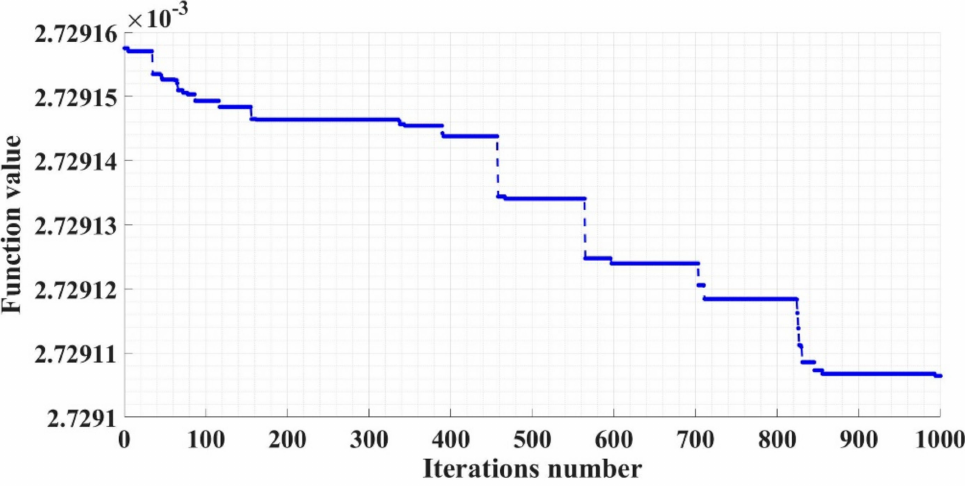
Figure 14. Evolution of the performance of the SA-type